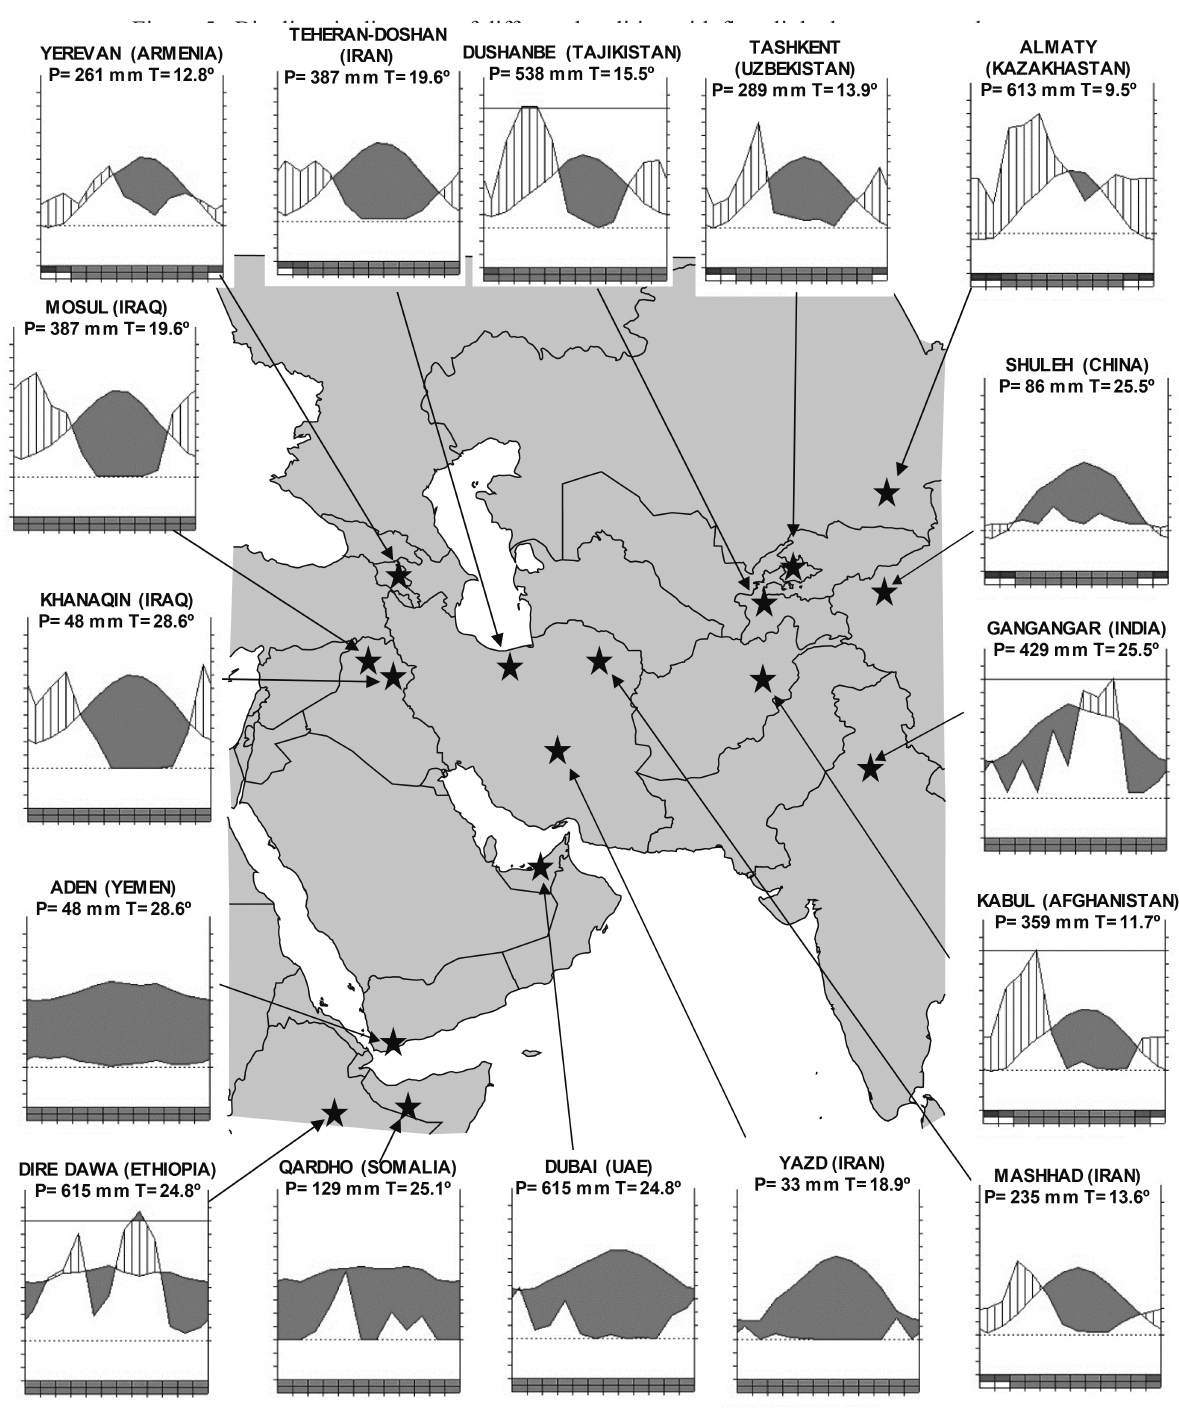
Figure 6. Bioclimatic diagrams of different localities with flora linked to gypsum substrates, from the Middle East, Central Asia and the Horn (Retrieved from